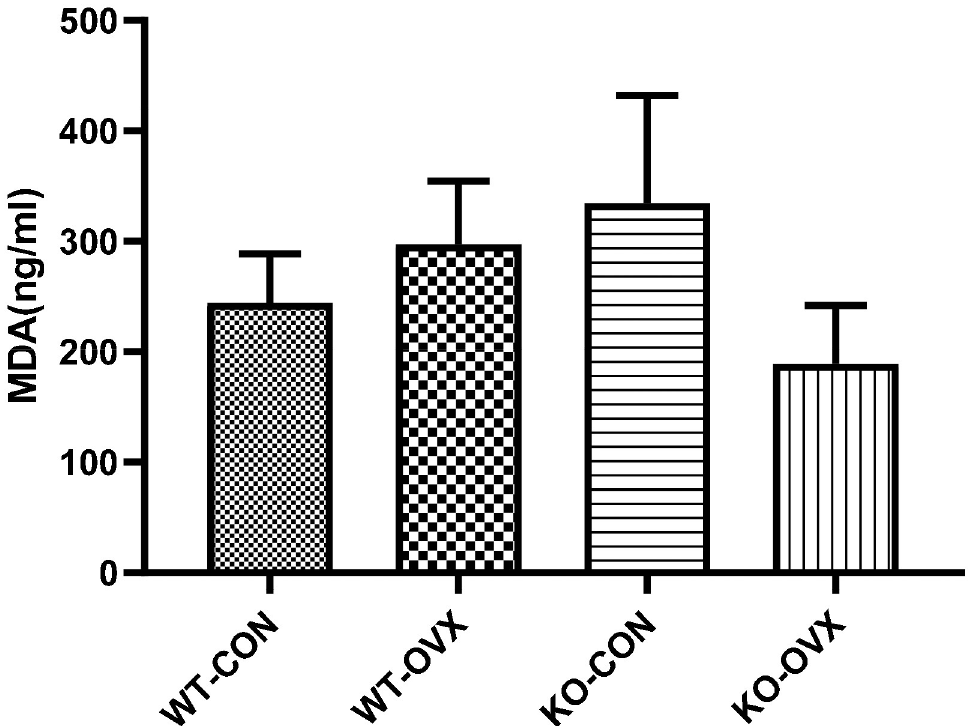
Fig 2. Comparison of malondialdehyde (MDA) levels in different groups of mice. WT-CON: wild-type control, WT-OVX: wild-type ovariectomy, KO-CON: Nrf2−/− control, KO-OVX: Nrf2−/− ovariectomy. Serum MDA concentration at postoperative week 9 was measured in different groups. Results are shown as mean ±